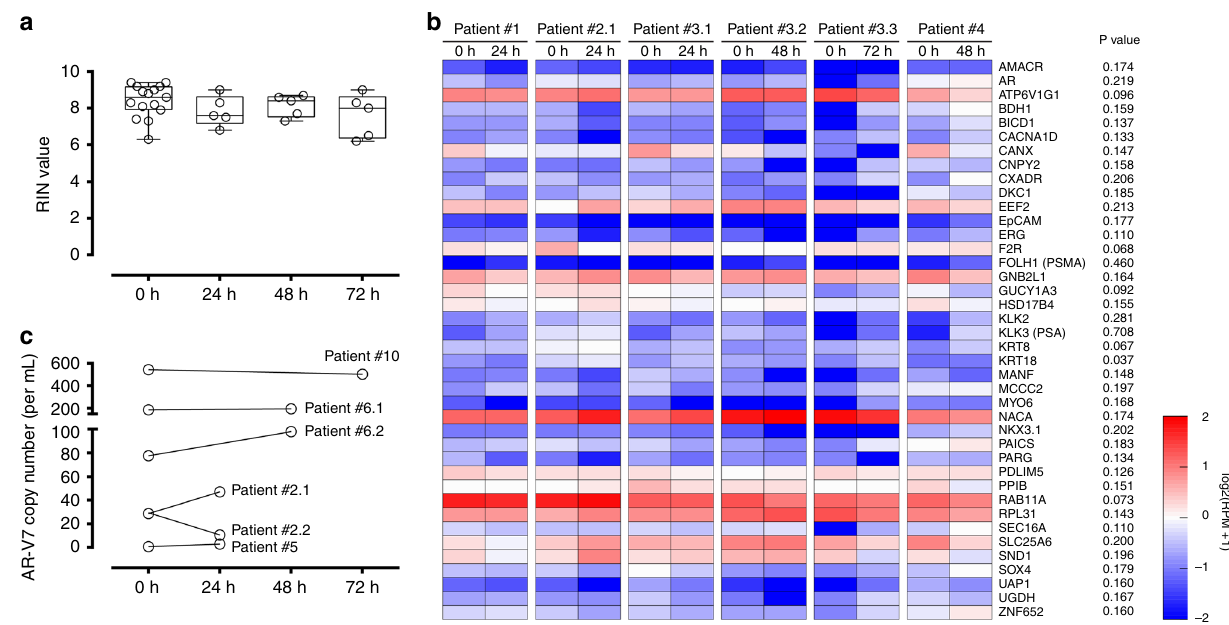
Fig. 5 CTCs isolated from prostate cancer patient blood contain intact RNA for RNA sequencing and Droplet Digital PCR after whole blood preservation. a RIN values of CTCs isolated from fresh and cold-stored blood (total 15 blood draws from 8 independent patients). b Scaled heatmap of log2-transformed normalized reads (RPMs) for four prostate cancer patients. For patient #3, data are available from three different draw dates stored for different durations (24, 48, and 72 h; denoted #3.1, #3.2, and #3.3, respectively). Statistical analysis comparing fresh vs. cold-stored blood (6 blood draws) found no signi fi cant differences in the mean RPMs for any of the 40 genes depicted in b , except for KRT18 ( p = 0.037, paired t -test). c The mRNA copy number of AR-V7 detected by Droplet Digital PCR (expressed as per mL of blood processed). Box-and-whiskers plots show median, interquartile range, maxima, and